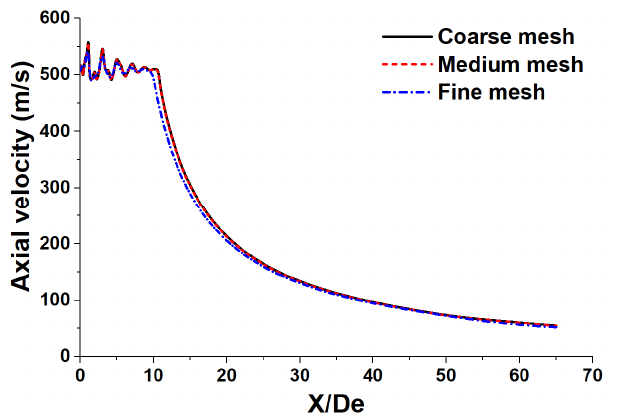
Figure 3. The axial velocity distribution of the supersonic jet at the jet centerline using various mesh levels.